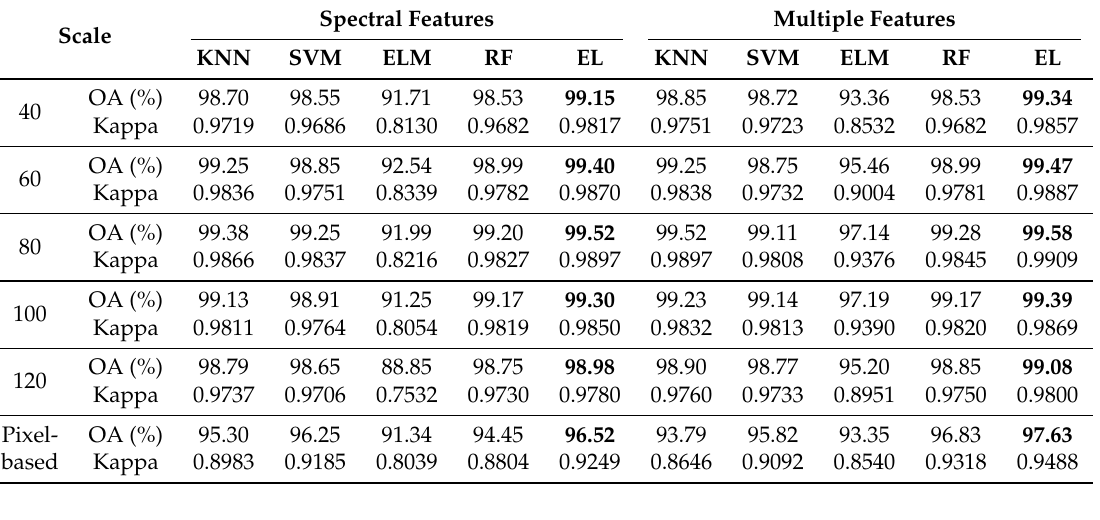
Table 3. Overall accuracies of change detection and Kappa coefficients of Experiment B for different segmentation scales and feature selection strategies.